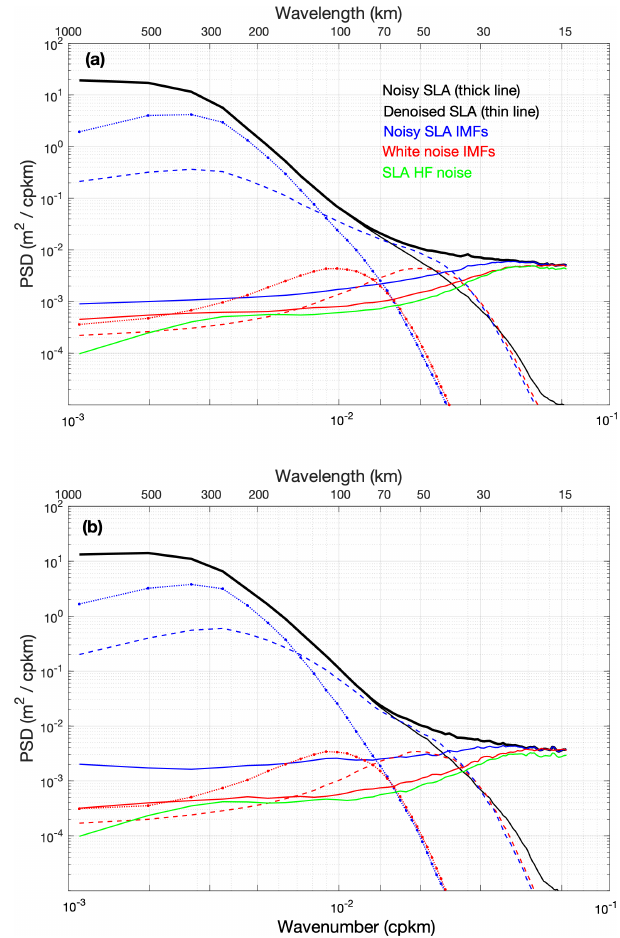
Figure 2. Mean PSD of the first three IMFs (first = solid; sec- ond = dashed; third = dotted) for white noise (red curves) and SARAL SLA along-track measurements (blue curves), and mean PSD of the corresponding noisy (thick black line) and denoised (thin black line) SLA measurements. The PSD is the average of PSDs computed over all data segments covering the years 2016– 2018, for the Agulhas (10–35 ◦ W; 33–45 ◦ S, a ) and Gulf Stream (72–60 ◦ W; 44–32 ◦ N, b ) regions. The green line is for the PSD of the SLA high-frequency noise estimated from the SLA’s IMF1 (solid blue